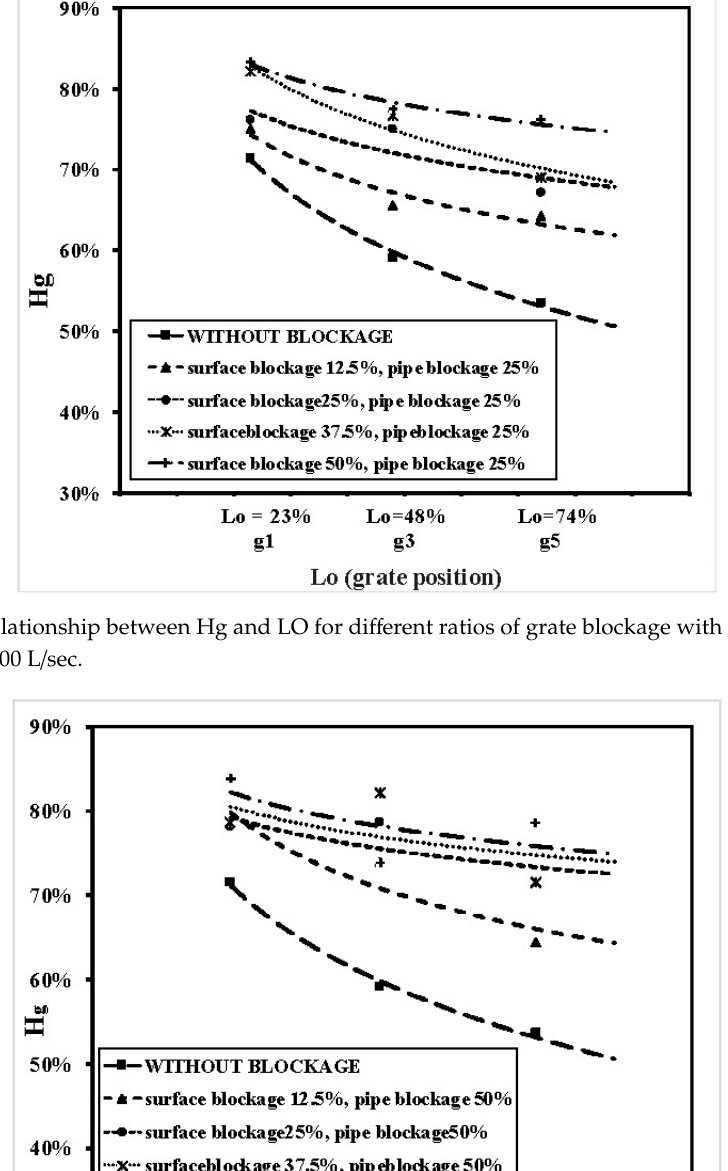
ff erent ratios of grate blockage with pipe blockage